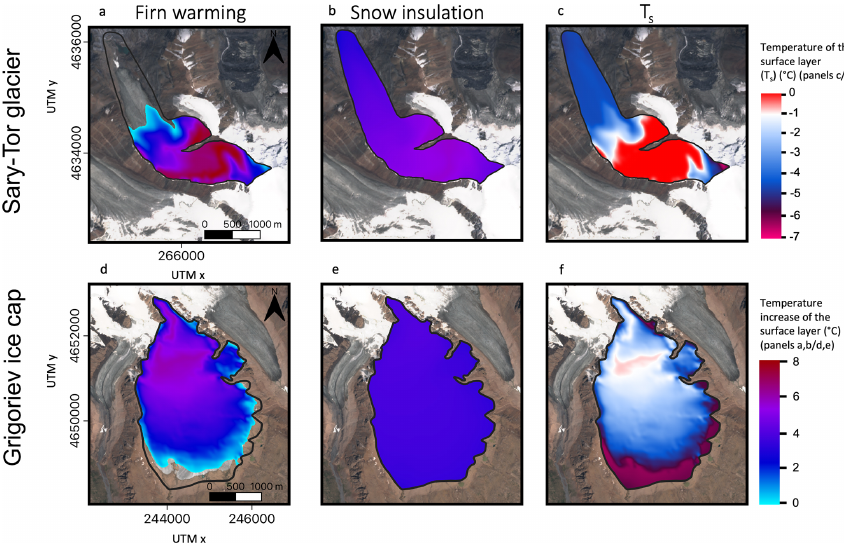
Figure 6. Warming due to refreezing of meltwater (firn warming) (panels a and d ), due to snow insulation (panels b and e ) and resulting mean annual surface layer temperature ( T s ) (panels c and f ) for both ice masses according to constant 1960–1990 average climatic conditions and masked for the 1990 outline (black lines). The background is a Sentinel-2 image from 26 July 2021. The x and y axes in (a) and (d) apply to the other panels as